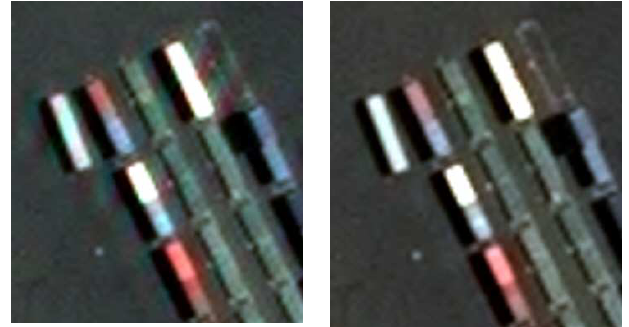
Figure 12 pan-sharpened Pleiades images for initial (left) and improved (right) merging